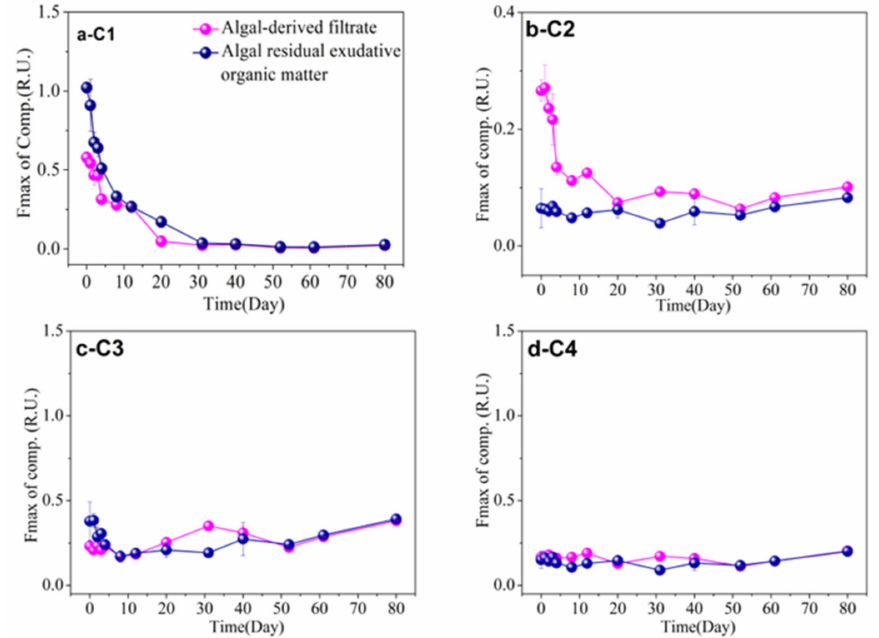
Figure 7. Dynamic changes in the main components of fluorescent dissolved organic matter (FDOM) during the 80-d degradation processes of algal-derived filtrate and algal residual exudative organic matter groups. ( a ) C1, ( b ) C2, ( c ) C3, and ( d )